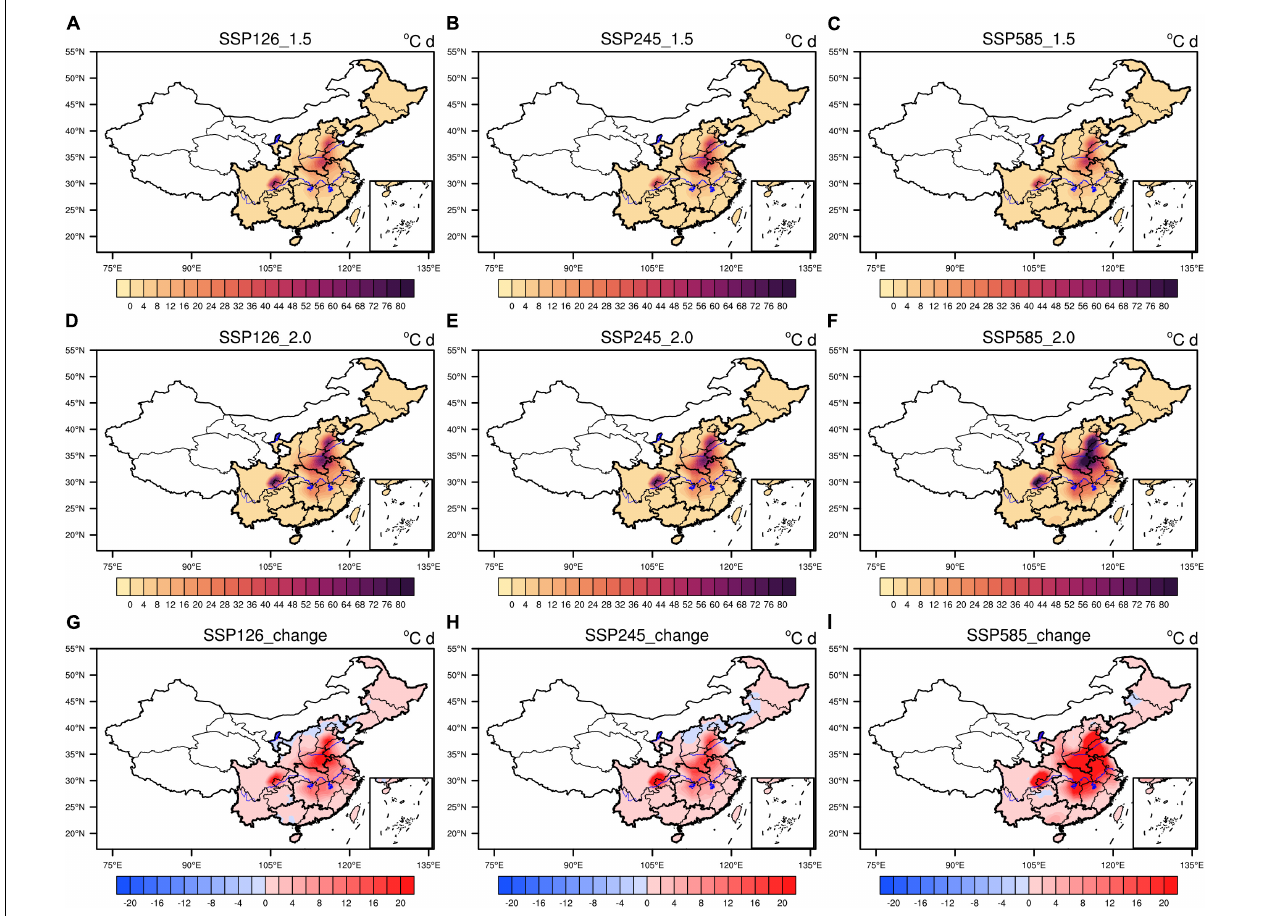
FIGURE 12 | Distribution of rice heat damage index (Ha) at 1.5 and 2 ◦ C. (A–C) Global warming at 1.5 ◦ C under SSP126, SSP245, and SSP585, respectively. (D–F) Global warming at 2 ◦ C under SSP126, SSP245, and SSP585, respectively. (G–I) The differences between global warming at 1.5 and 2 ◦ C.